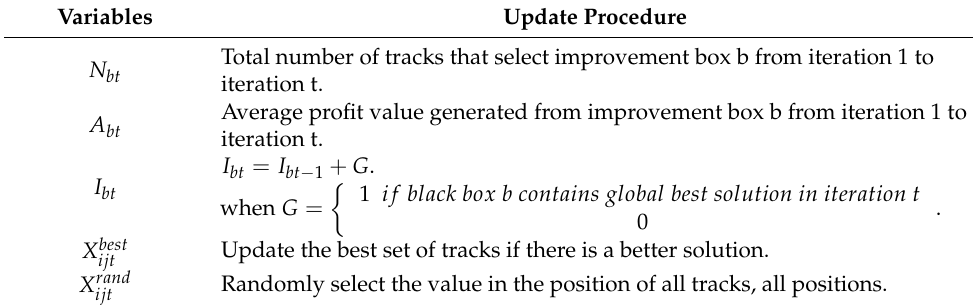
Table 5. Update rule for heuristics information.